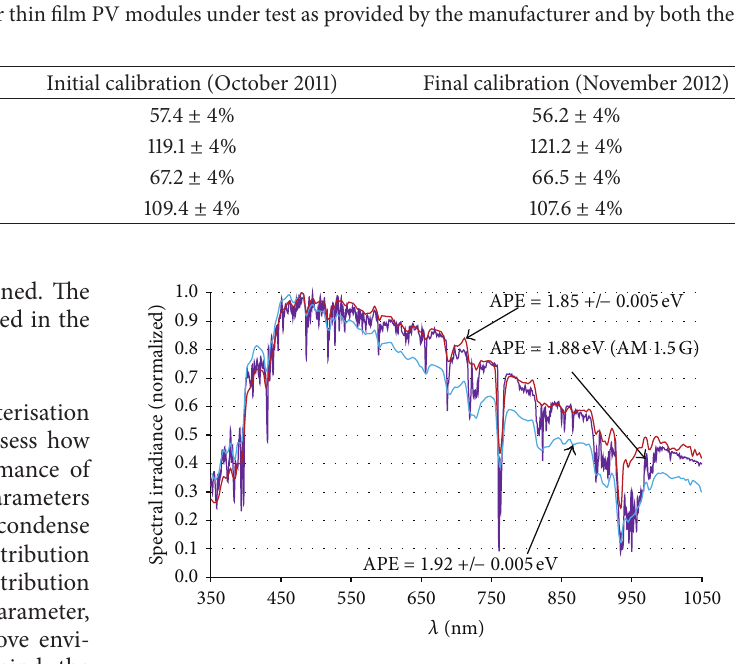
Figure 1: Incident spectral irradiance distributions normalized to their maxima. Redder spectra imply lower values of APE. Data corresponding to the reference AM 1.5G spectrum have been obtained from the IEC 60904-3